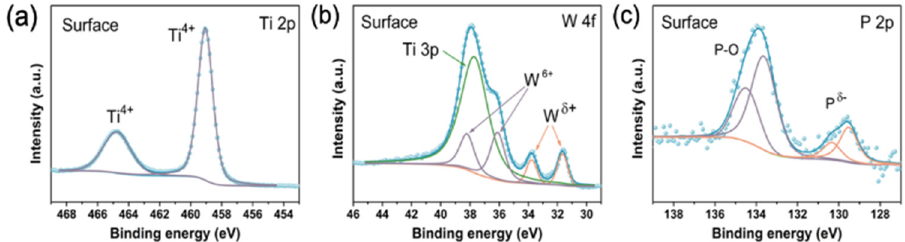
Figure 9. XPS survey of WP/TiO 2 on a Si surface. ( a ) Ti 2p spectrum, ( b ) W 4f spectrum and ( c ) P 2p spectrum from the surface of WP/TiO 2 . Reprinted/adapted with permission from Ref. [62]. 2021, ACS Publications.